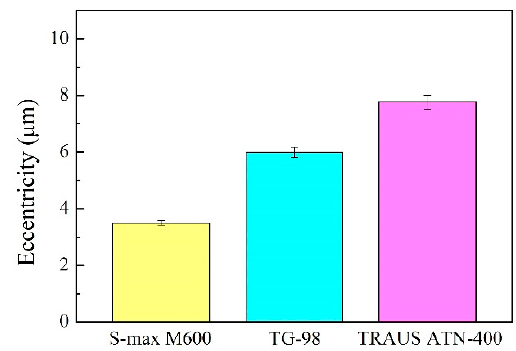
Figure 6. Eccentricities of the three kinds of high-speed handpieces.